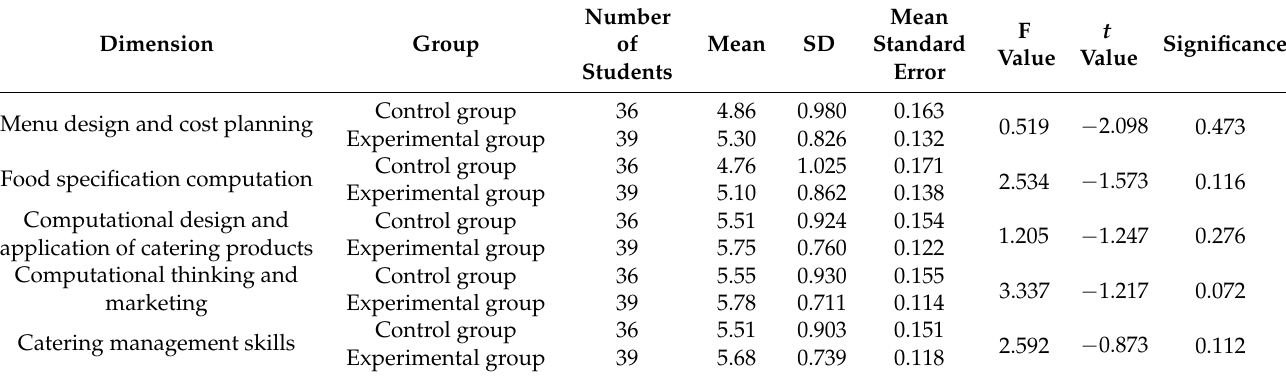
Table 3. Summary of independent-sample t -tests for the pretest learning effectiveness of the two groups.